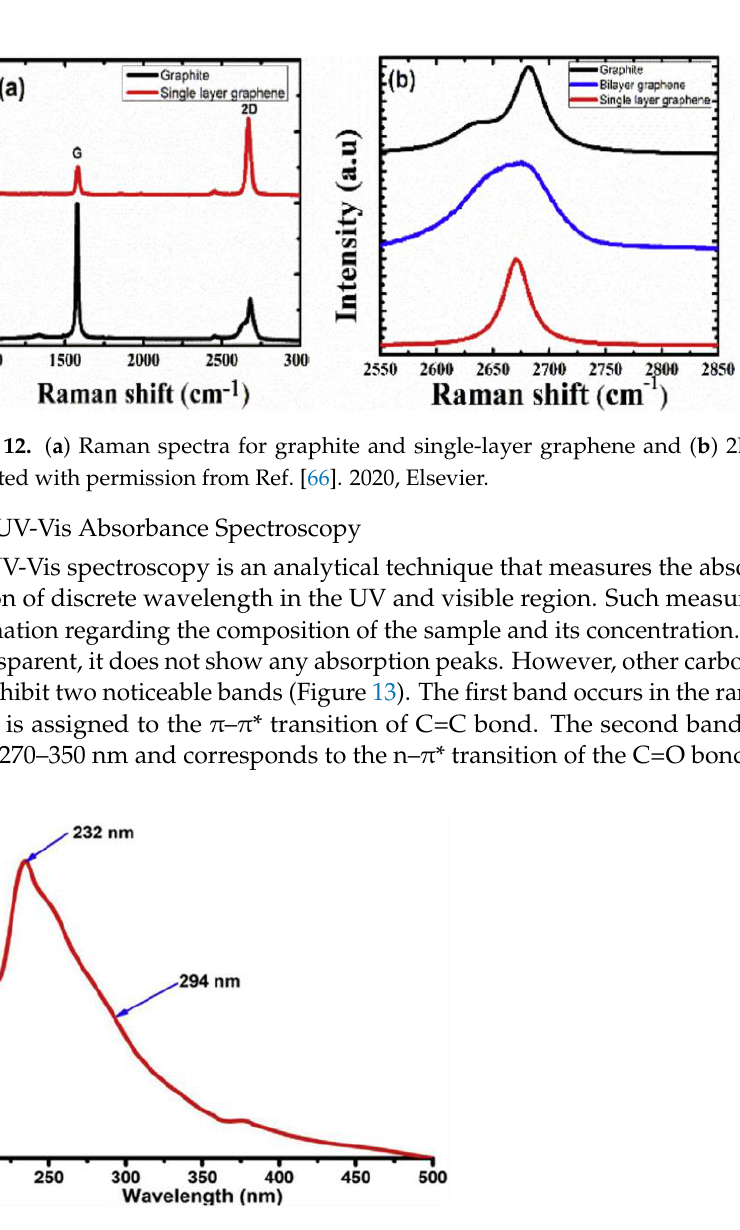
Figure 13. UV-Vis absorbance spectrum of graphene-oxide nanostructures. Reprinted with permis- sion from Ref. [63]. 2019, Elsevier.